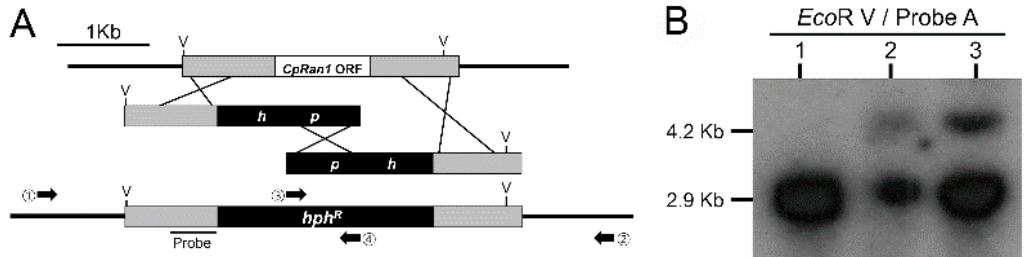
Figure 2. Restriction map and Southern blot analysis of the wild-type EP155/2 and the CpRan1 -null mutant. ( A ) Restriction map of the CpRan1 genomic region and the gene replacement split makers replacing the CpRan1 ORF region with the hygromycin B resistance cassette flanked by 1035-bp and 980-bp fragments as the 5 ′ - and 3 ′ -flanking regions, respectively. The CpRan1 -null mutant with the desired replacement at CpRan1 is represented in the map with the expected changes in the size of the restriction fragments. Flanking regions and expected replacing ORF region are indicated by shadows and open boxes, respectively. hph R , indicated by the dashed box, represents the hygromycin B resistance cassette. Genes outside the replacement vector are indicated by lines. V represents restriction endonuclease Eco RV. ( B ) Southern blot analysis of the wild-type EP155/2 strain (lane 1) and two heterokaryotic CpRan1 -null mutants (lanes 2, 3; note that in order to compare the intensity of hybridizing bands, two different amounts (10 µ g and 20 µ g) of genomic DNA were used for lanes 2 and 3, respectively.). Enzyme/probe combination is indicated above the line, and the probe A is indicated in the restriction map in the upper panel ( A